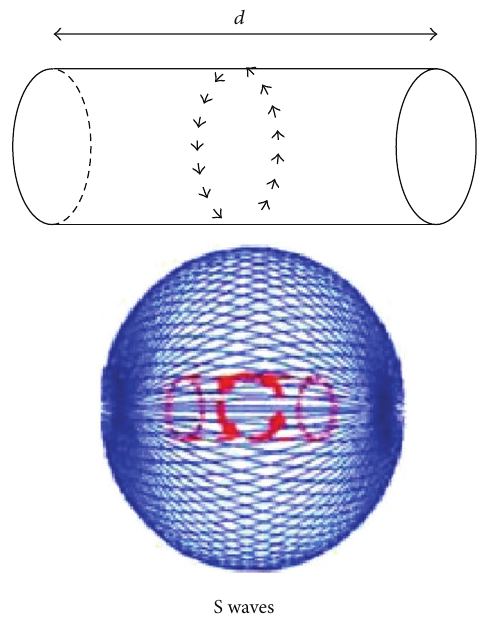
Figure 9: Diagrams of propagation of waves created by tangential stress at alveole contour in length 𝑑 .